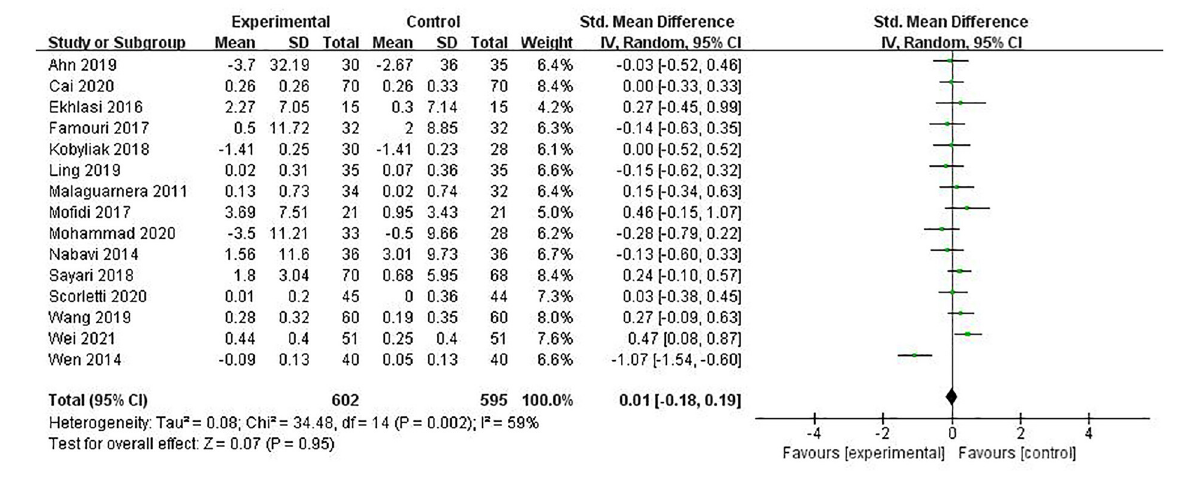
FIGURE8 The role of PPS in LDL-C in patients with NAFLD.